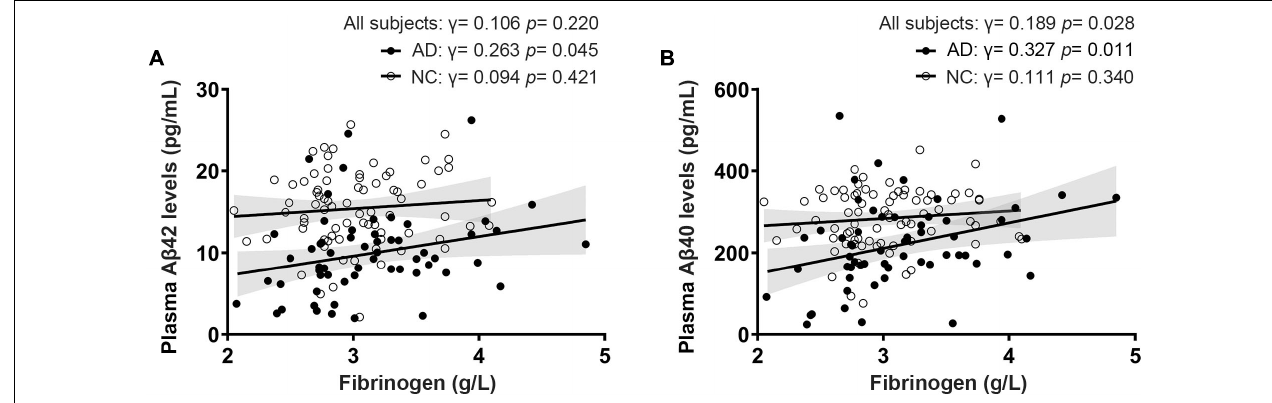
FIGURE 2 | Correlations between fibrinogen levels with plasma A β 42 levels (A) and A β 40 levels (B) in AD patients diagnosed by positive PiB-PET and normal controls (NC).